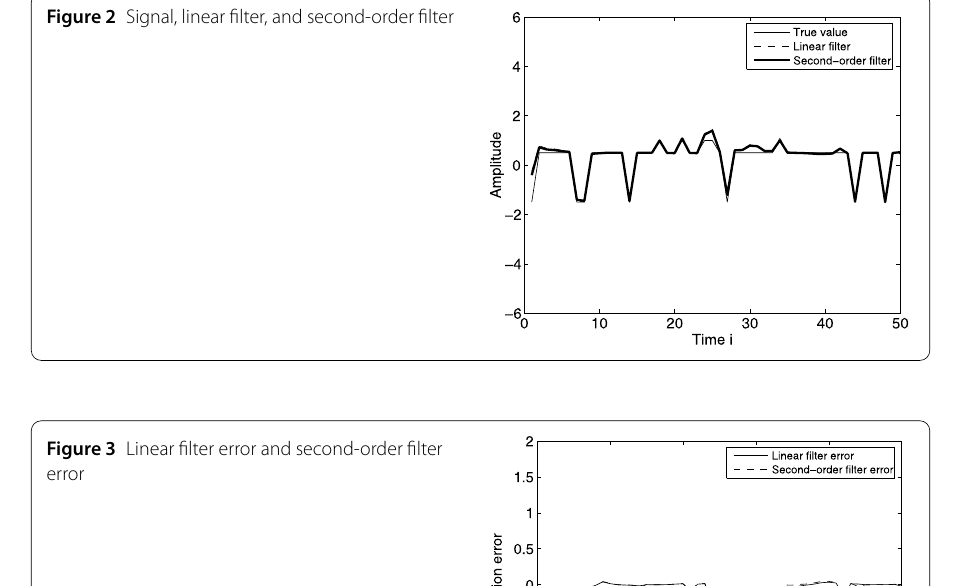
Figure 2 Signal, linear filter, and second-order filter